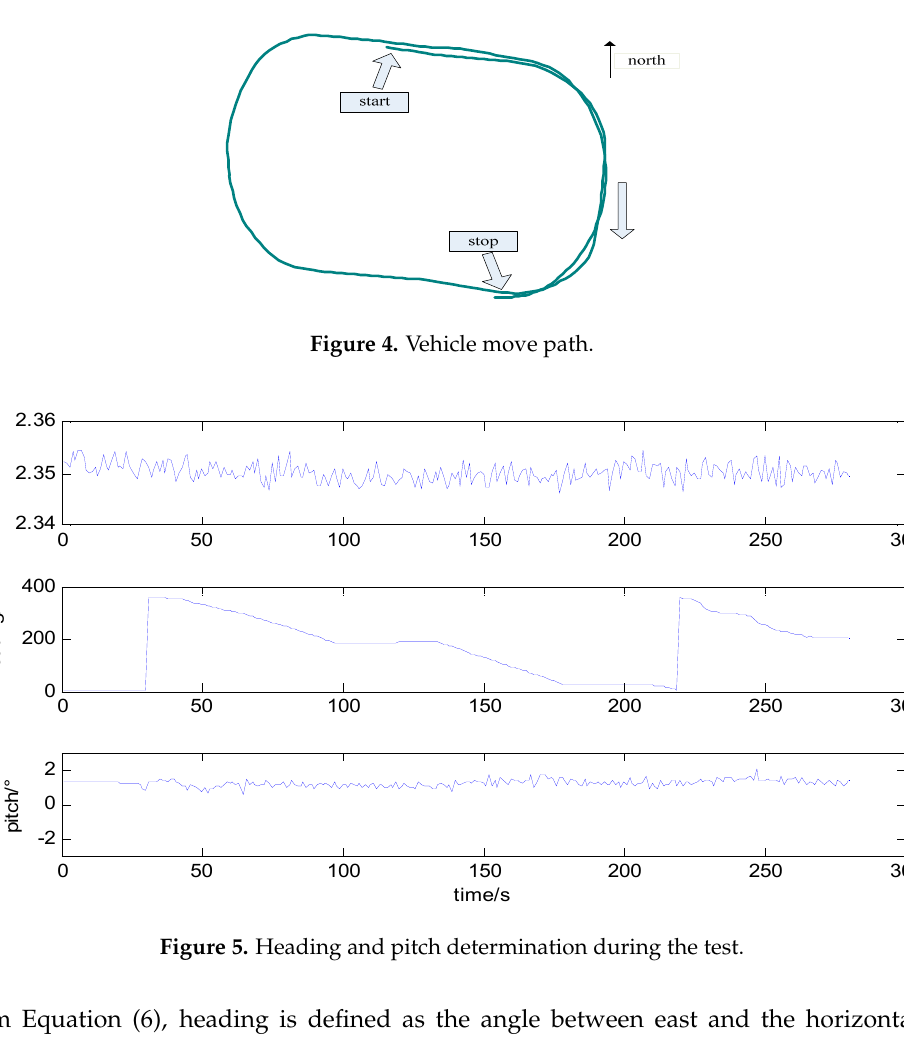
Figure 4. GNSS determined baseline length and attitude are shown in Figure 5.